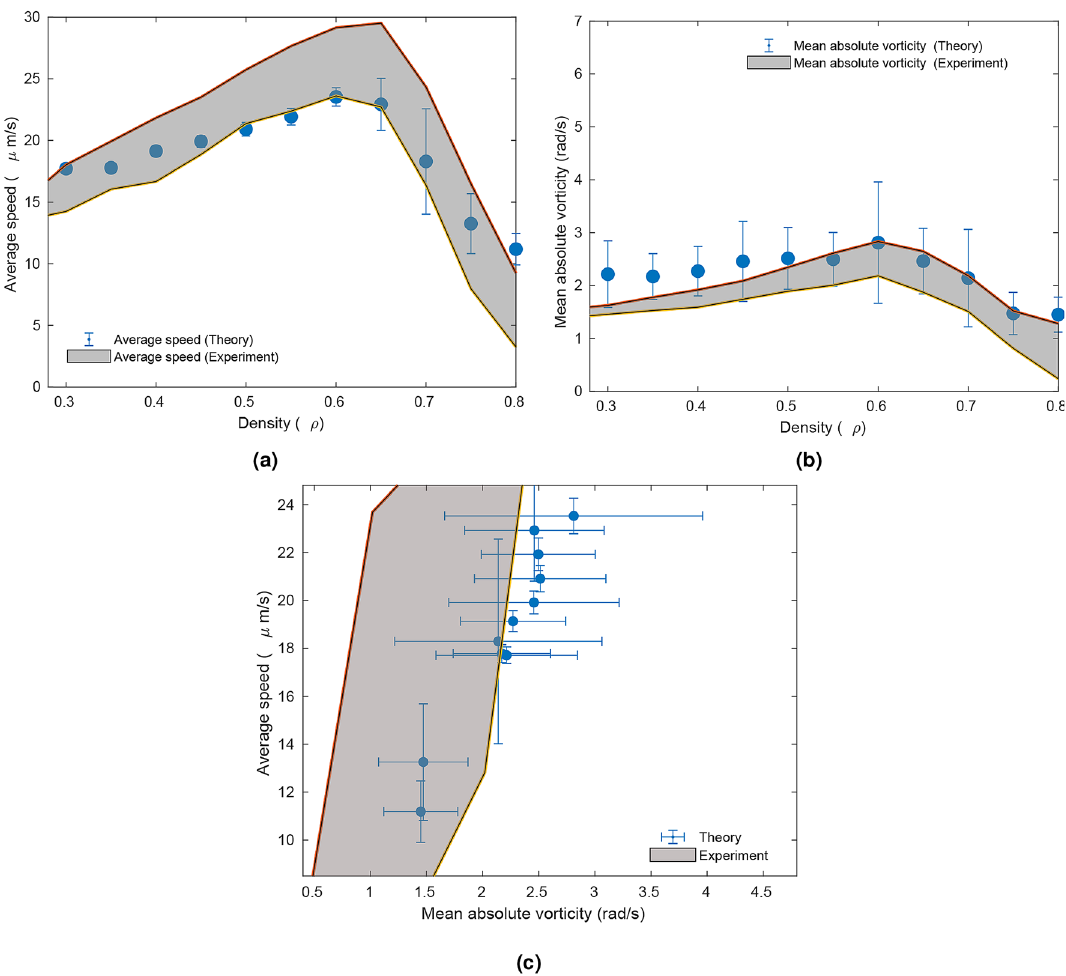
Figure 6. Comparison between vorticity trends in experiments and in simulations. ( a ) Relation between the average speed and the density. The simulation values shown are averaged over fifty realizations. ( b ) Dependence of the spatially normalized averaged absolute value of vorticity on the density. The simulation values shown are averaged over fifty realizations. ( c ) Relation between average speed versus mean absolute vorticity from simulations for various densities over fifty realizations. Experimental values were taken from 25 . Throughout all simulations, the standard deviation of the noise was set at 0.0001, interaction radius at R = 10 , proportionality constant ε = 0.008 , radial sensitivity β v = − 20 , g = 1 v and angular sensitivity at β θ = 5 . Data was obtained n after 500 time